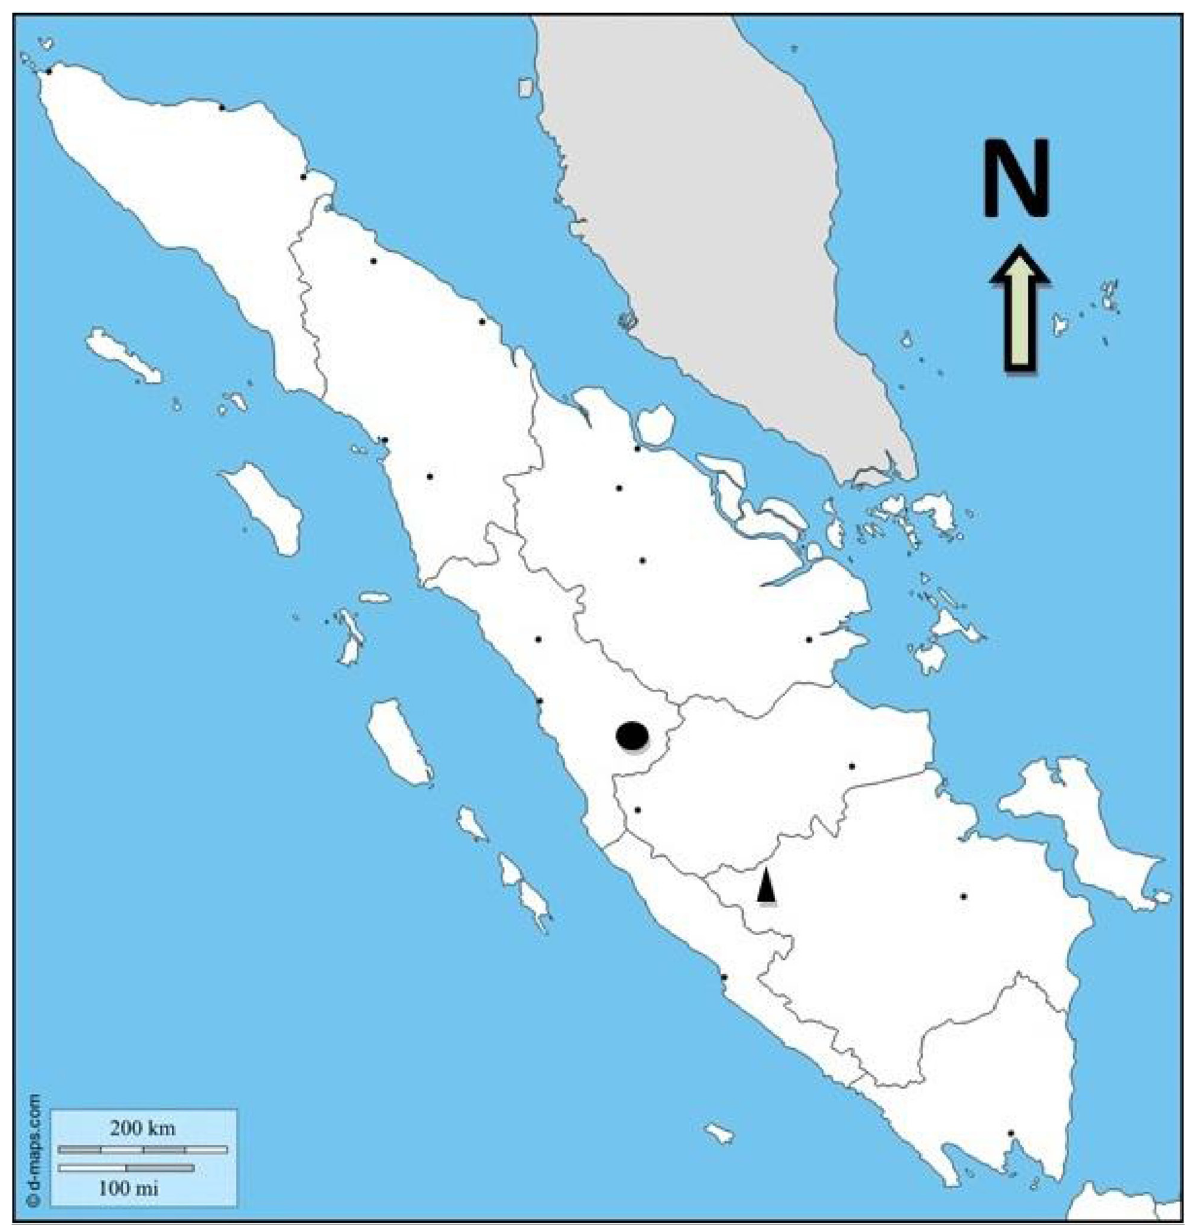
Figure 1. Known distribution of Crossocheilus obscurus . Black circle = type locality in the Batang Hari basin (West Sumatra); black triangle = additional locality at the Musi basin (South Sumatra).